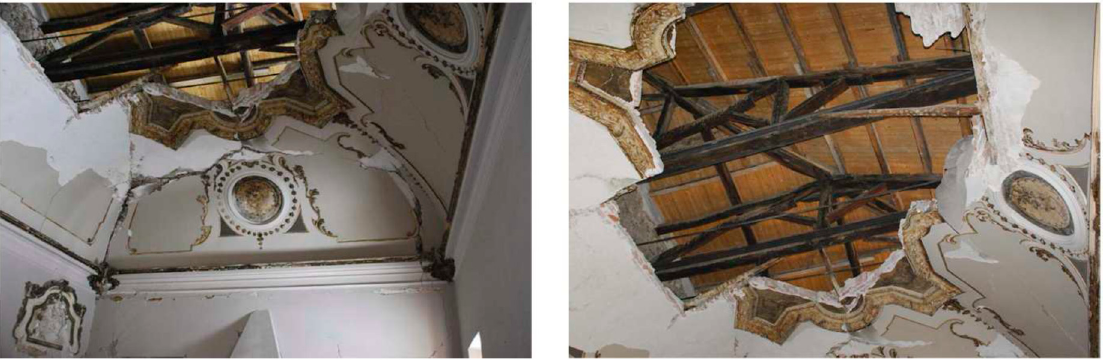
Figure 16. Pictures of the partially fallen vault.